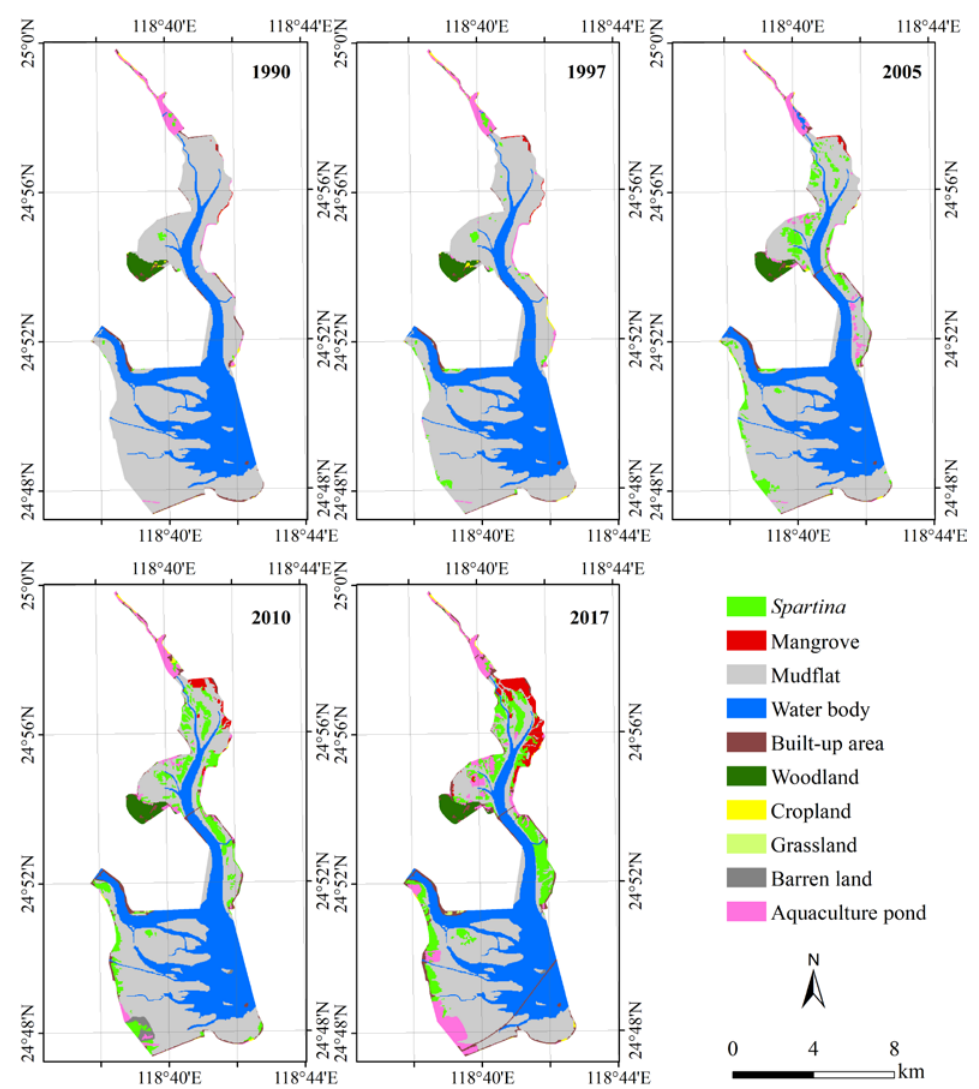
Figure 4. Land cover maps of Quanzhou Bay Estuary Wetland Nature Reserve (QBEWNR) from 1990 to 2017. Table 3. Summary of land cover classification accuracies from 1990 to 2017.